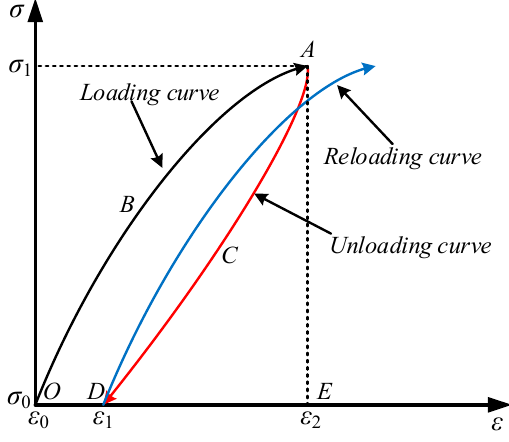
Figure 5. Schematic diagram of energy density calculation.